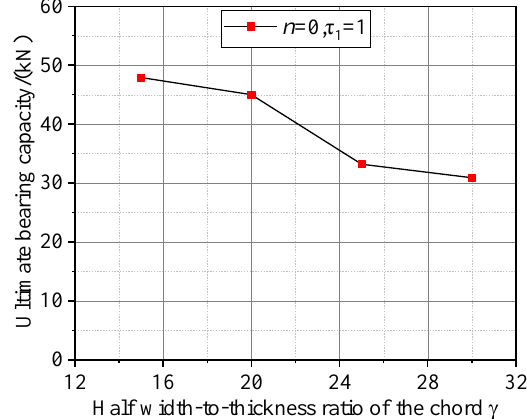
Figure 26. Effect of γ.